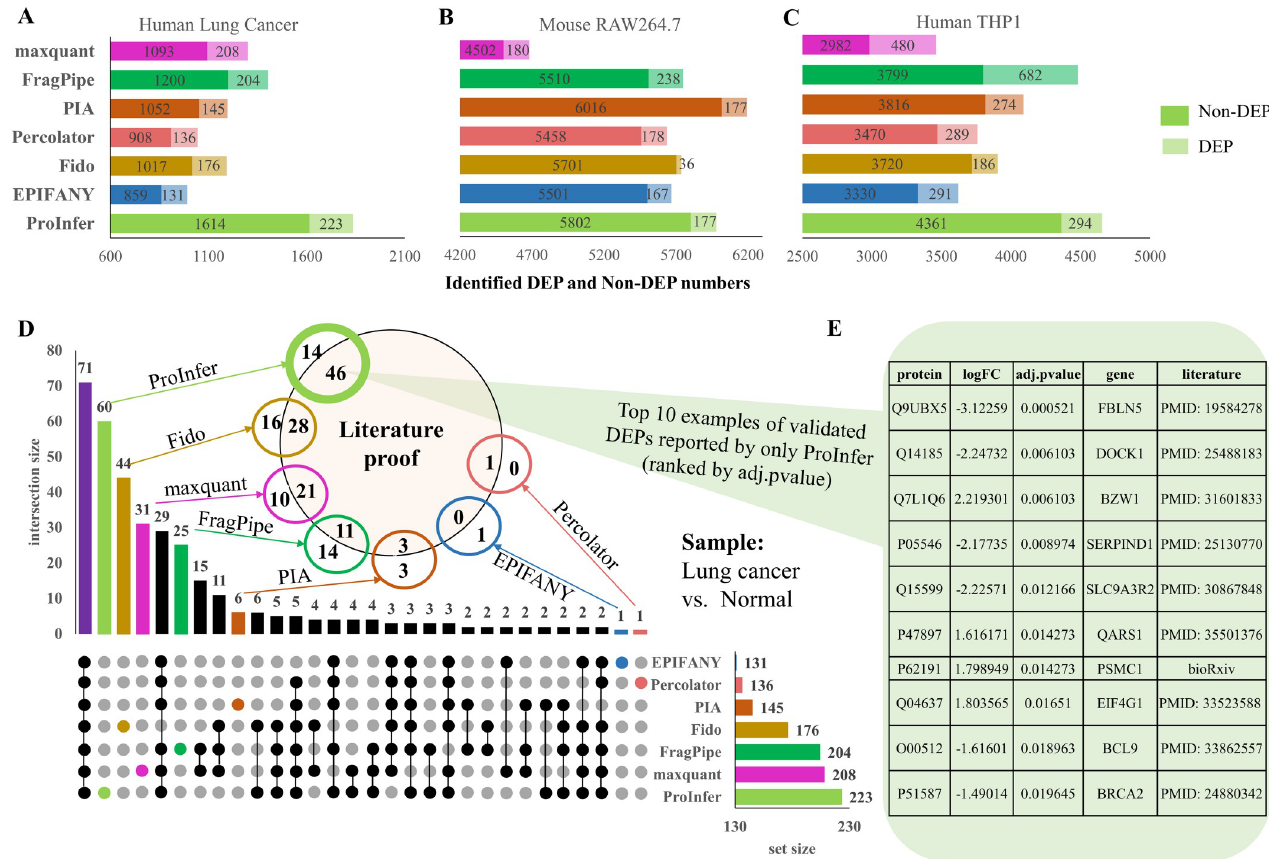
Fig 3. Evaluation of methods on differential expression analysis. A, B & C show the numbers of differentially expressed proteins (DEPs) and non- differentially expressed proteins (Non-DEPs) found by different protein inference tool-based, FragPipe and maxquant-based workflows from lung cancer, RAW264.7 and THP1 cell line data. D shows overlapping of DEPs reported by different workflows from lung cancer data and the validation status of those uniquely found DEPs. E gives the top10 example validation proofs of DEPs uniquely found by